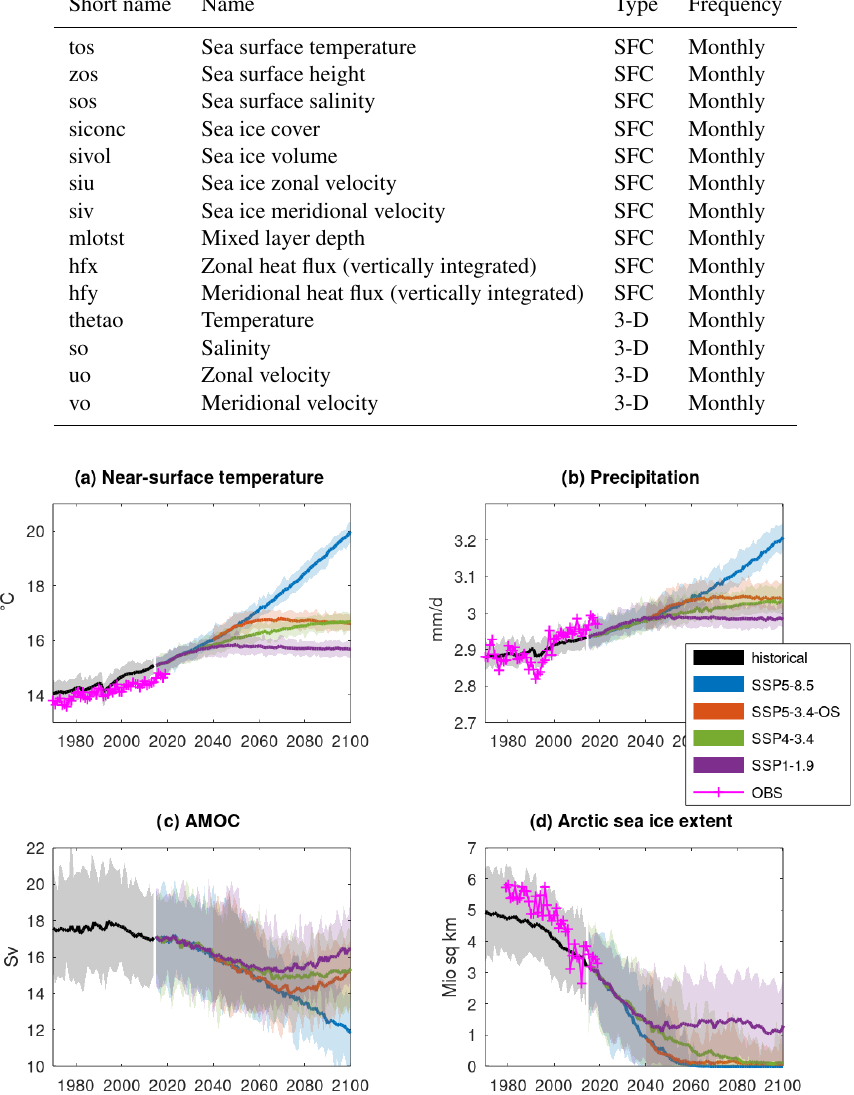
Figure 2. Time series of global annual mean near-surface temperature, precipitation, AMOC, and minimum Arctic sea ice extent in the historical and scenario experiments. Thick lines denote the ensemble means and shaded area the full ensemble width. The scenarios branch off from the historical experiment in 2015 except for SSP5-3.4-OS, which branches off from SSP5-8.5 in 2040. The magenta lines marked with plus signs denote ERA5 (Hersbach et al., 2020) for temperature and precipitation and the OSI-450 sea ice observations (Lavergne et al.,